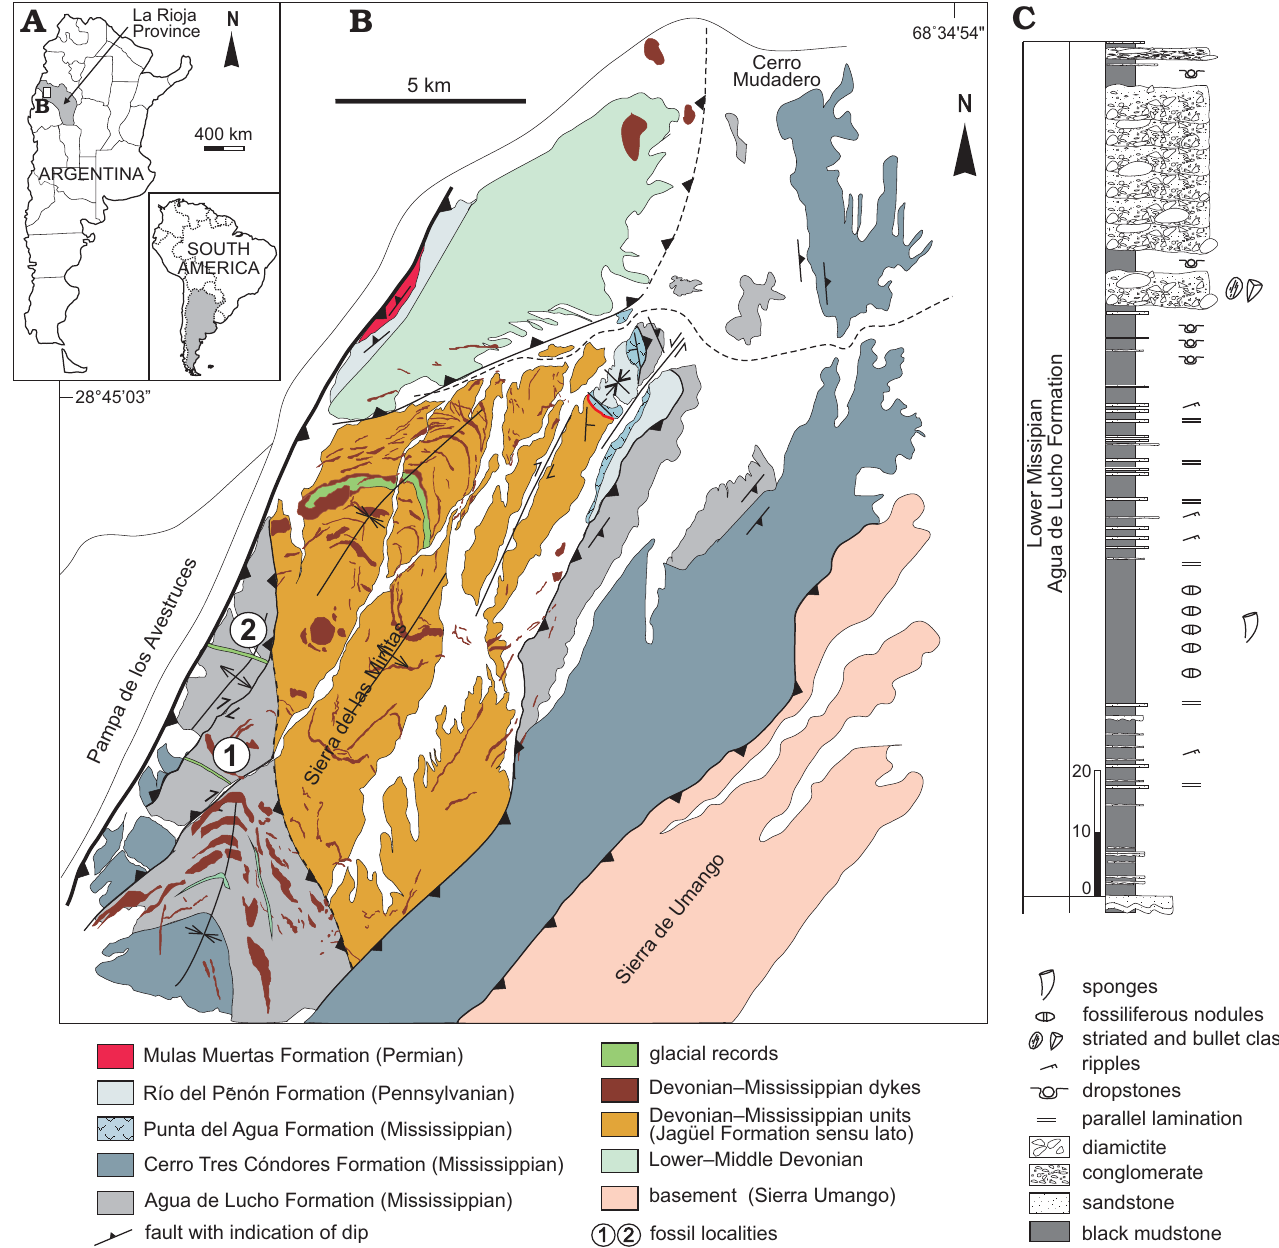
Fig. 1. A . Geographic location of the studied area. B . Geological map and location of the studied section. The west flank of the Agua Quemada Syncline is divided in some tectonic blocks (1 and 2) by inverse and dextral strip faults. Sponges come from nodules of equivalent fine-grained dark stratigraphical intervals of the Agua de Lucho Formation (Tournaisian), cropping out under glacigenic diamictitic in both tectonic blocks. C . Stratigraphic column of the Agua de Lucho Formation and the location of the sponge-bearing